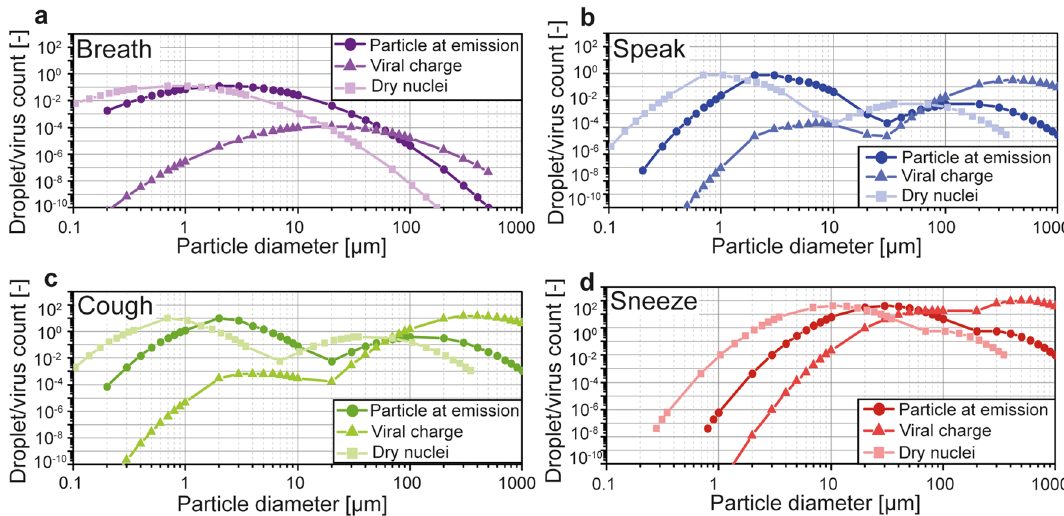
Figure 2. Size distributions based on the number of generated particles and the corresponding viral charge, as well as the number distributions considering the dry nuclei sizes, for breathing ( a ), speaking ( b ), coughing ( c ), and sneezing ( d ). The total particle counts in each distribution corresponds to the average values given in Table S4 and represent one minute for breathing and speaking, and one occurrence for coughing and sneezing. The viral charge was calculated considering a homogeneous concentration of viral charges in the liquid fraction of the droplets equal to 7 × 10 6 RNA copies/mL 37 . The particle counts were normalized, taking the total number of particles emitted while breathing as reference for each size and expiratory activity. The viral charge was obtained by multiplying the normalized count and the viral charge per particle.